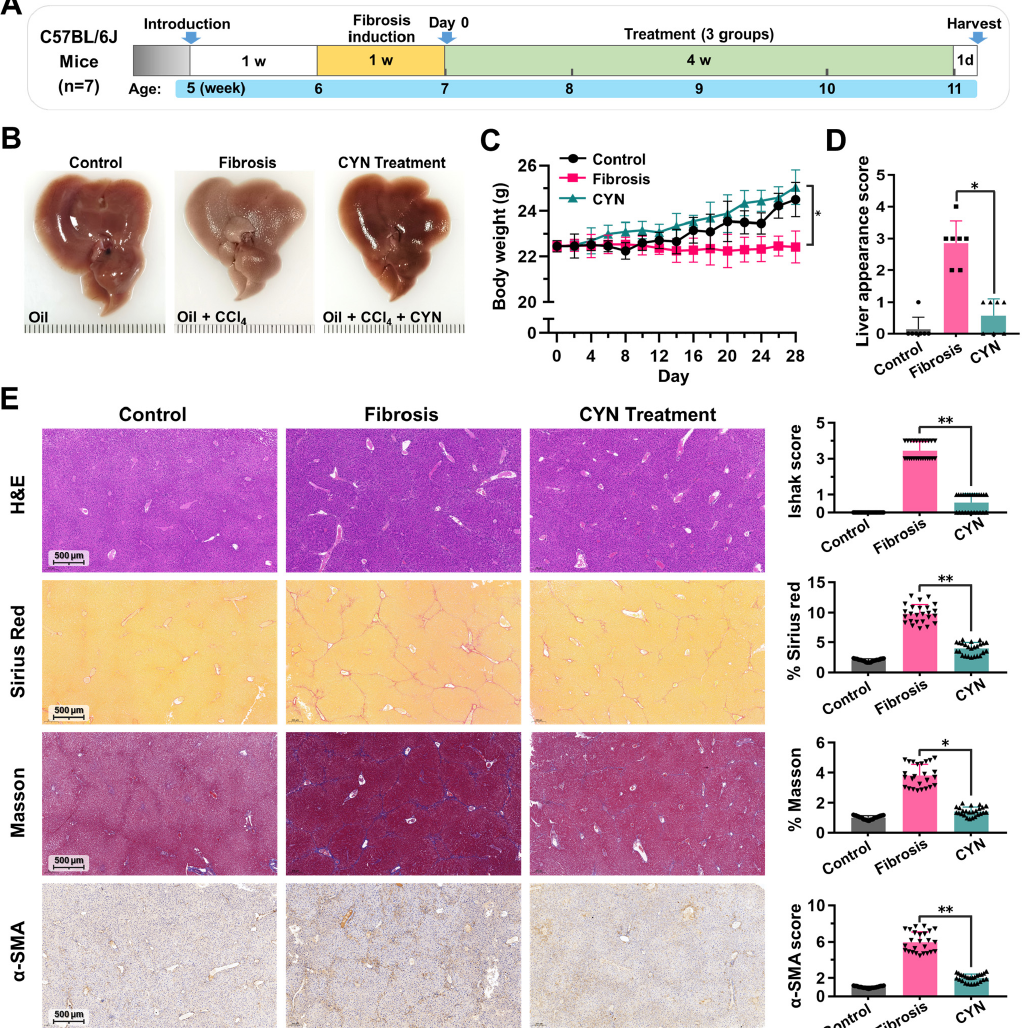
Figure 5. CYN attenuates the progression of CCl 4 -induced liver fibrosis. ( A ) Schematic of the animal experiment. ( B ) Liver appearance at the time of sample collection. ( C ) The trend of mouse weight over time where Day 0 is the initial day of treatment. ( D ) Liver appearance score. ( E ) Results for liver sections stained with hematoxylin and eosin (H&E), Sirius Red, Masson, and immunohistochemistry (IHC)for α -SMA. The statistics are based on quantitative data from 25 random fields of view for all animals in this group. The results are marked as significant “*” when p < 0.05, “**” when p < 0.01, and not significant (ns) if p ≥ 0.05.